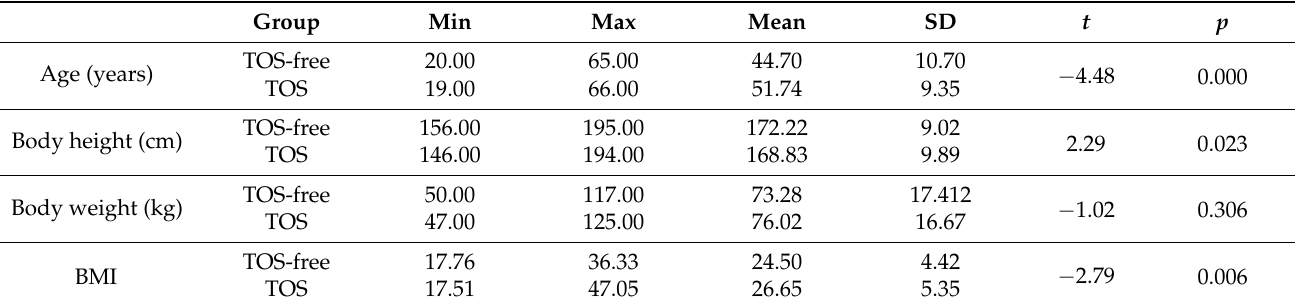
Table 2. Descriptive characteristics of the